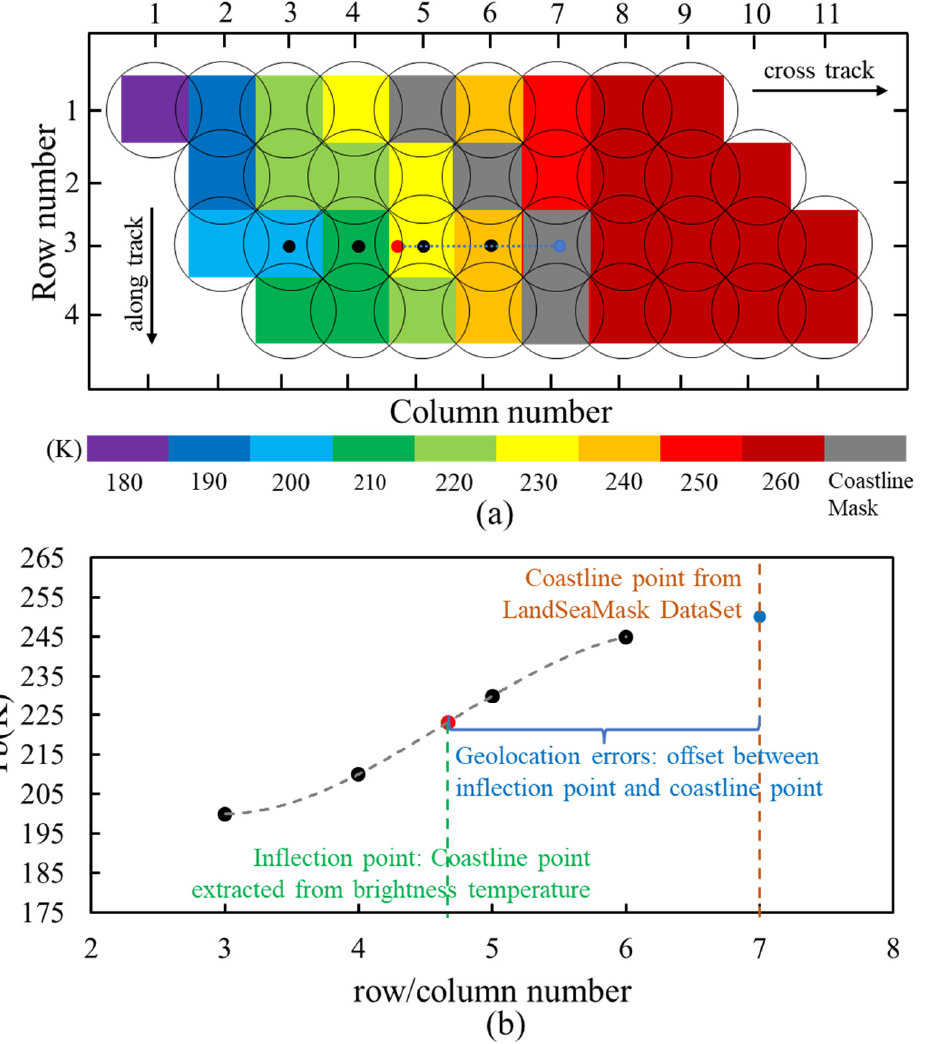
Figure 4. Diagram for finding coastline inflection points in the cross-track direction. The gray pixels are coastline pixels from LandSeaMask. The blue point is the center point of the coastline pixel, which represents the true coastline point. The red point is the coastline inflection point found by SICM. The colorful background in ( a ) represents changes of brightness temperature. ( b ) shows the BT changes of the coastline inflection